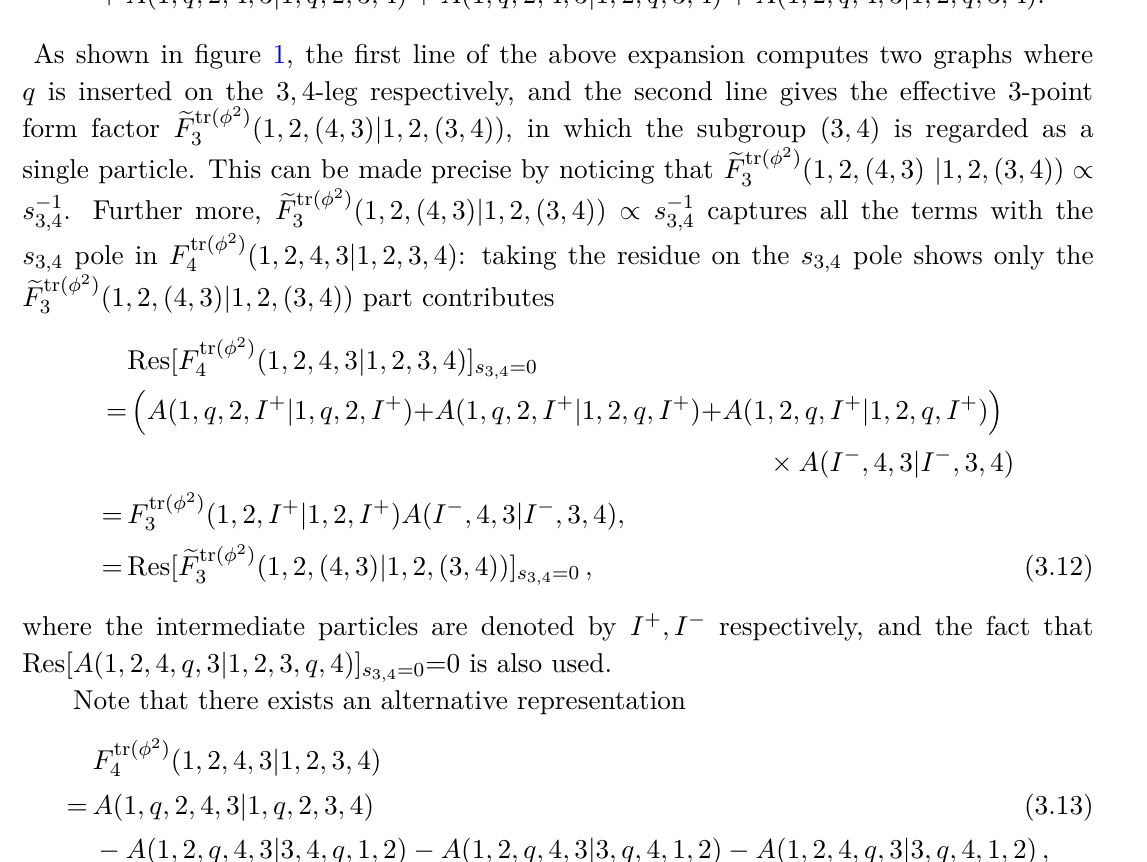
Figure 1. Feynman diagrams for F tr( φ large parenthesis is equivalent to the term before